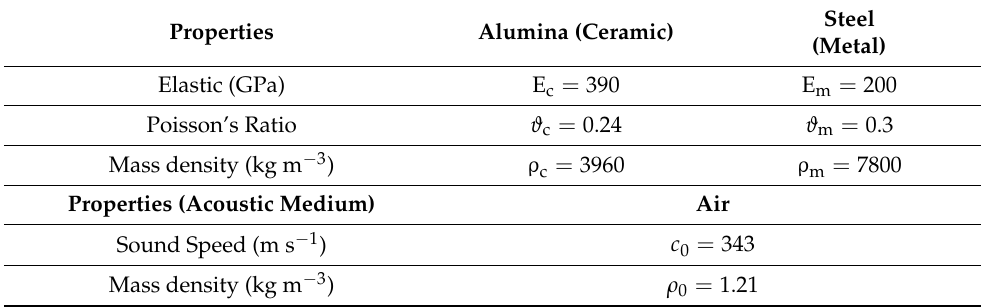
Table 2. A comparative study of the natural frequencies of an FG cylindrical shell.